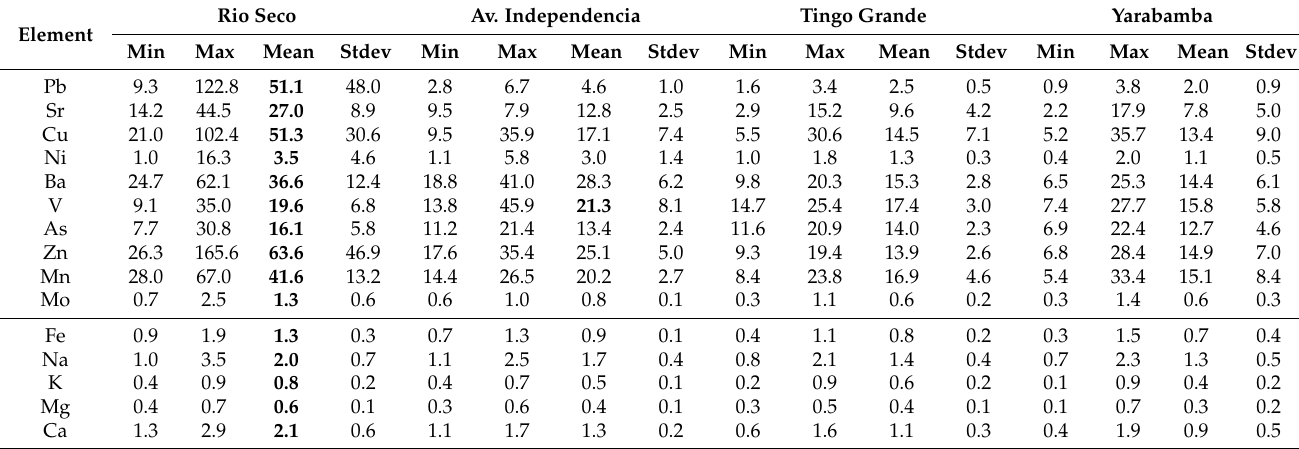
Table 1. Air concentration (in ng/m 3 ) of elements in each site. Highest mean concentrations are marked in bold font. The unit for trace elements (Pb-Mo) is ng/m 3 and for major elements (Fe-Ca) is µ g/m 3 .